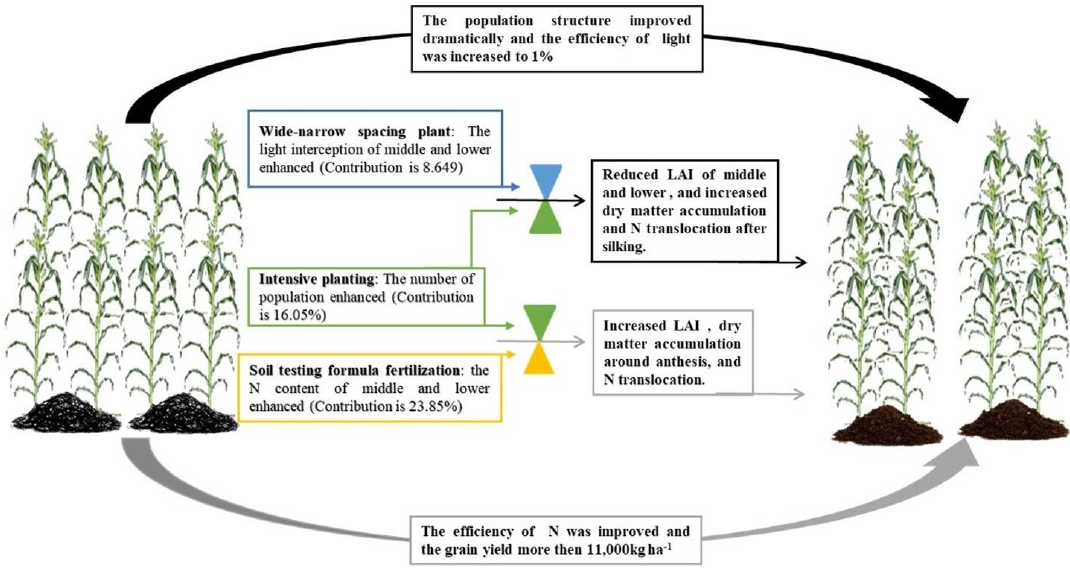
Figure 6. The regulatory mechanisms of fertilization, density, and wide ‐ narrow spacing plant on maize population in Northeast China.